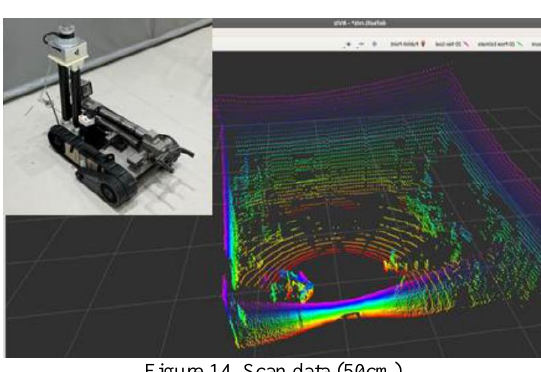
Figure 14. Scan data